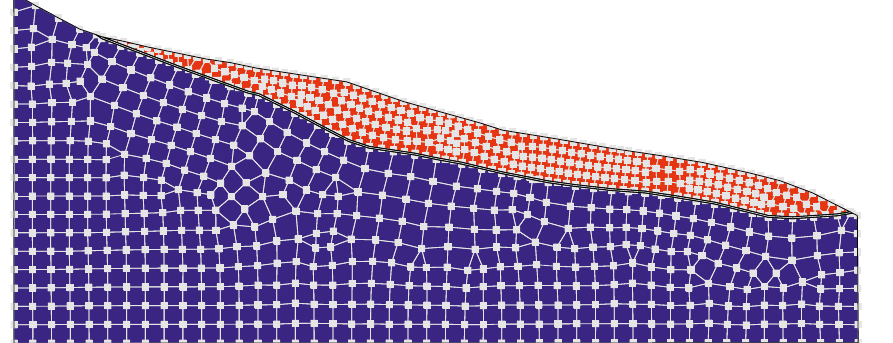
Figure 6: Zoning map of landslide